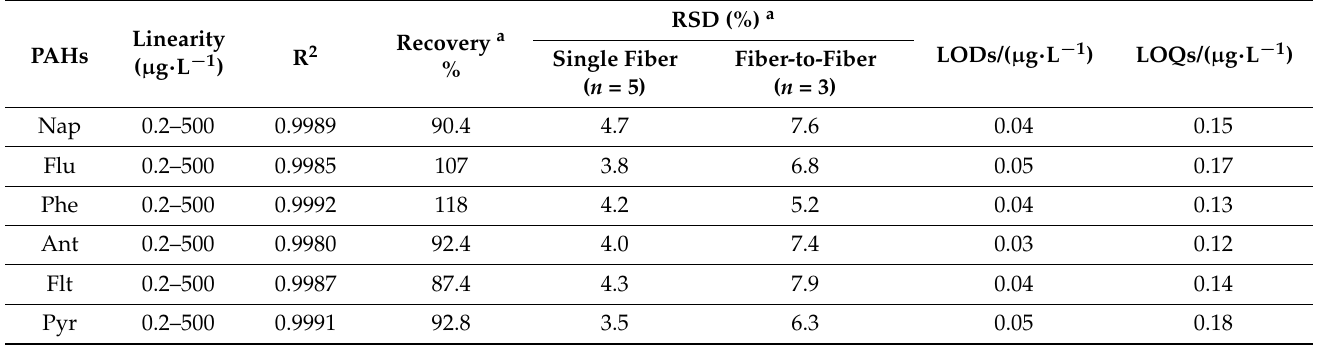
Table 1. Analytical parameters of the proposed method with the TiO 2 NTs/Ti fiber.